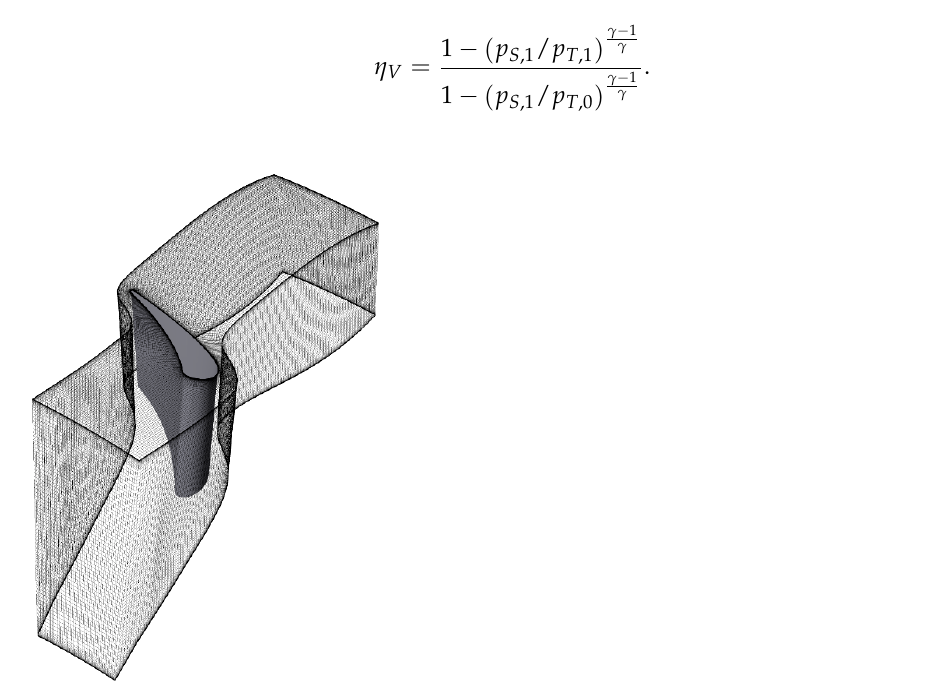
Figure 2. Fully hexahedral computational mesh employed for the CFD simulations.